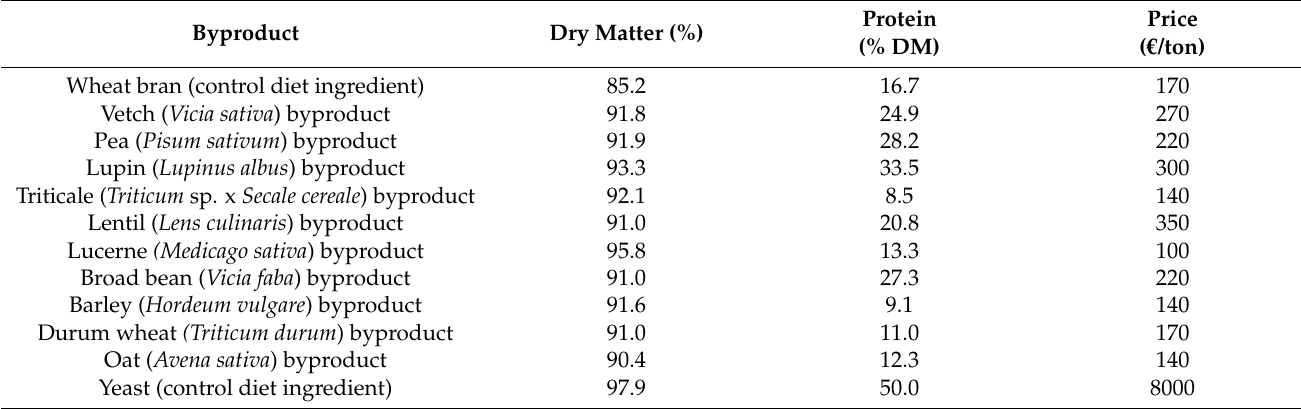
Table 1. Dry matter (%), protein content (%DM) and cost ( € /ton) of ten byproducts of the seed cleaning process of cereals and legumes and two control diet